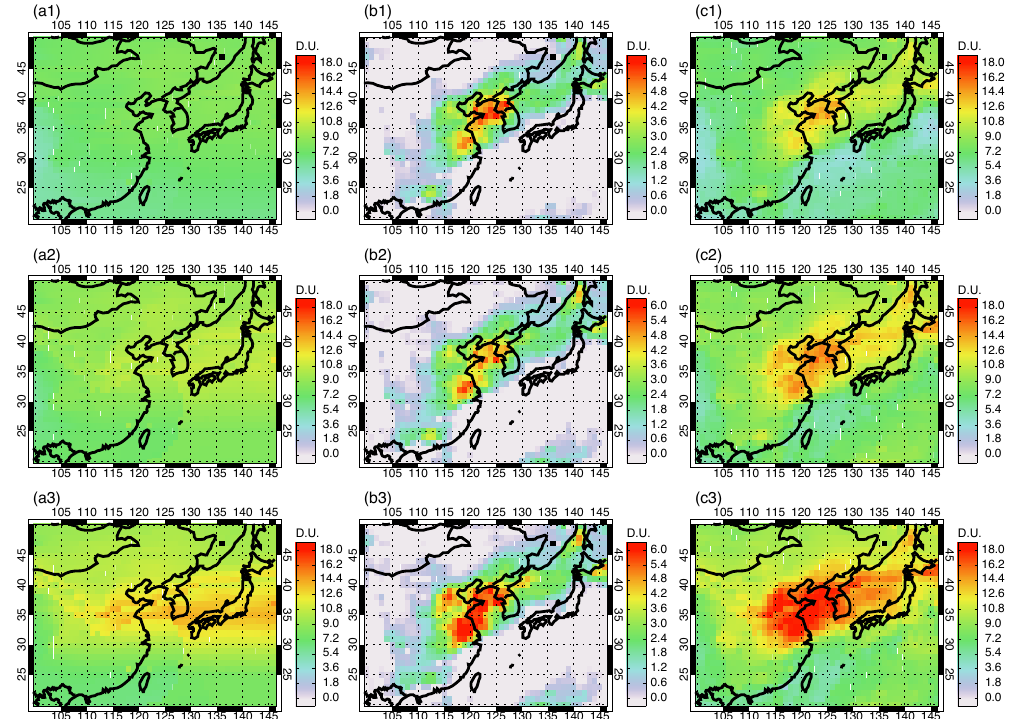
Figure 11. Maps of (a) a priori ozone, (b) OMI-derived (cid:49) O 3 , and (c) OMI-derived O 3 on 22 June 2005. 1, 2, and 3 represent the 22nd, 23rd, and 24th layers,